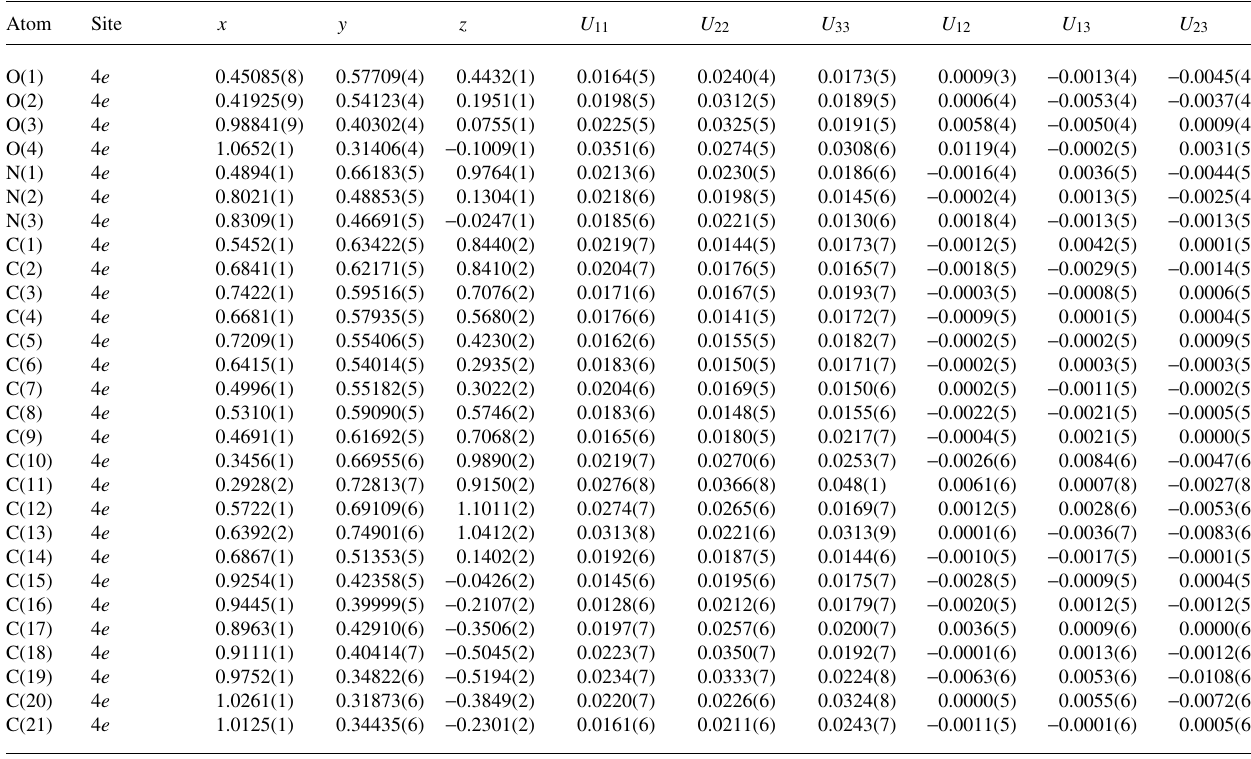
Table 3. Atomic coordinates and displacement parameters (in Å 2 )